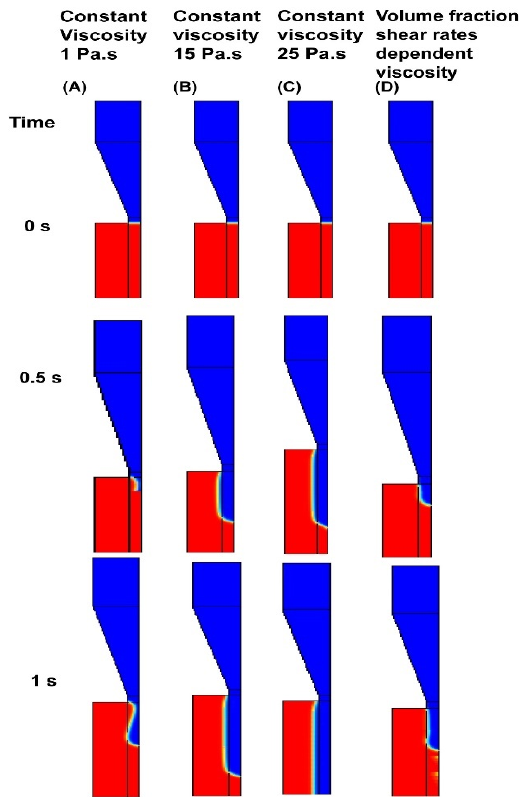
Figure 4. Influence of the viscosity on the behavior of the extruding hydrogel ink; ( A ) Constant viscosity = 1 Pa·s; ( B ) Constant viscosity 15 Pa·s; ( C ) Constant viscosity = 25 Pa·s; ( D ) Shear rate- dependent viscosity.